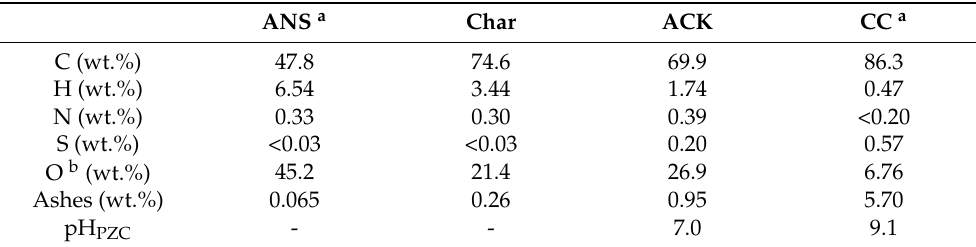
Table 3. Elemental analysis and ash content of the ANS, Biochar, ACK, and CC samples. ANS a Char ACK CC